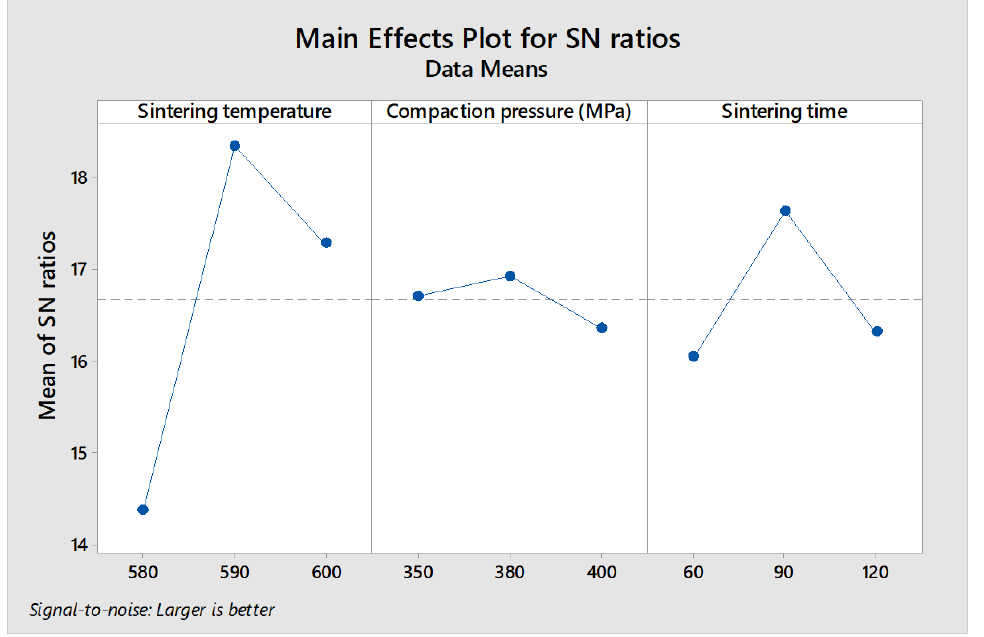
Figure 9. S/N ratio response curve of energy absorption capacity.